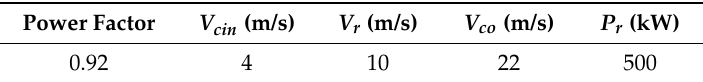
Table 1. Wind turbine